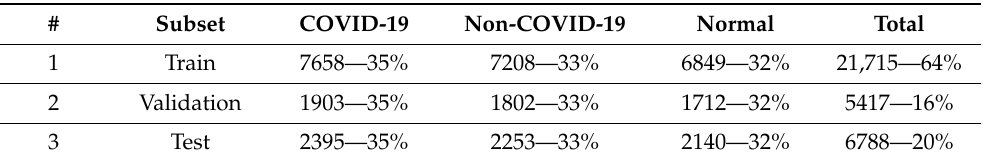
Table 1. Overall distribution of the data used in this